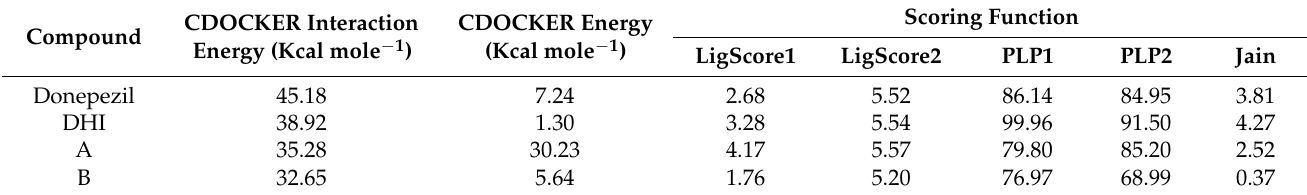
Table 5. Binding energies of the selected poses of DHI and test molecules.